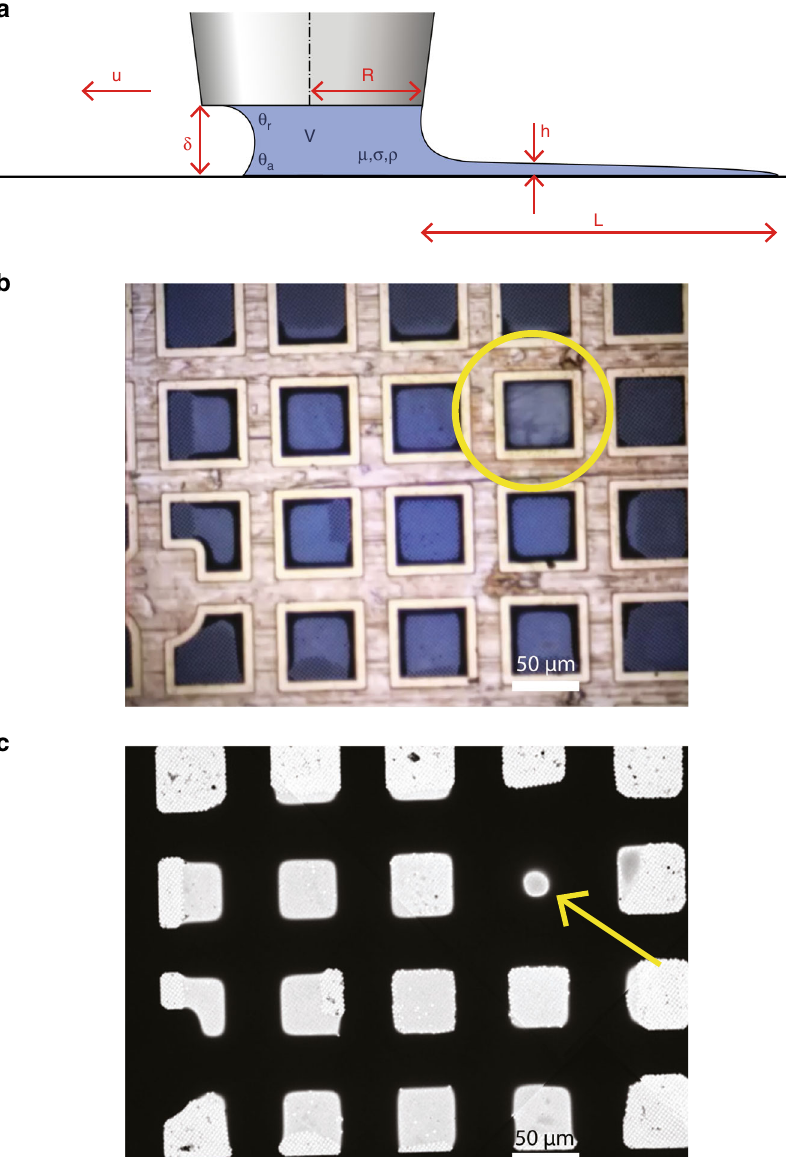
Fig. 2 Pin-printing parameters and resulting sample deposition. a Schematic overview of relevant parameters for pin printing. The deposited layer in height ( h ) and length ( L ) is a result of the sample properties (viscosity μ , surface tension σ , density ρ ), contact angles (advancing at the grid θ a , receding at the pin θ r ), and writing parameters (standoff distance δ , pin radius R , pin velocity u ). b Photograph of the grid by the integrated camera shows the sample applied by pin printing. The pin is indicated by a yellow circle. c Low magni fi cation cryo-EM atlas of the deposited and vitri fi ed sample. One thicker square (arrow) is the result of retraction of the pin from the grid. Scale bars represent 50 μ